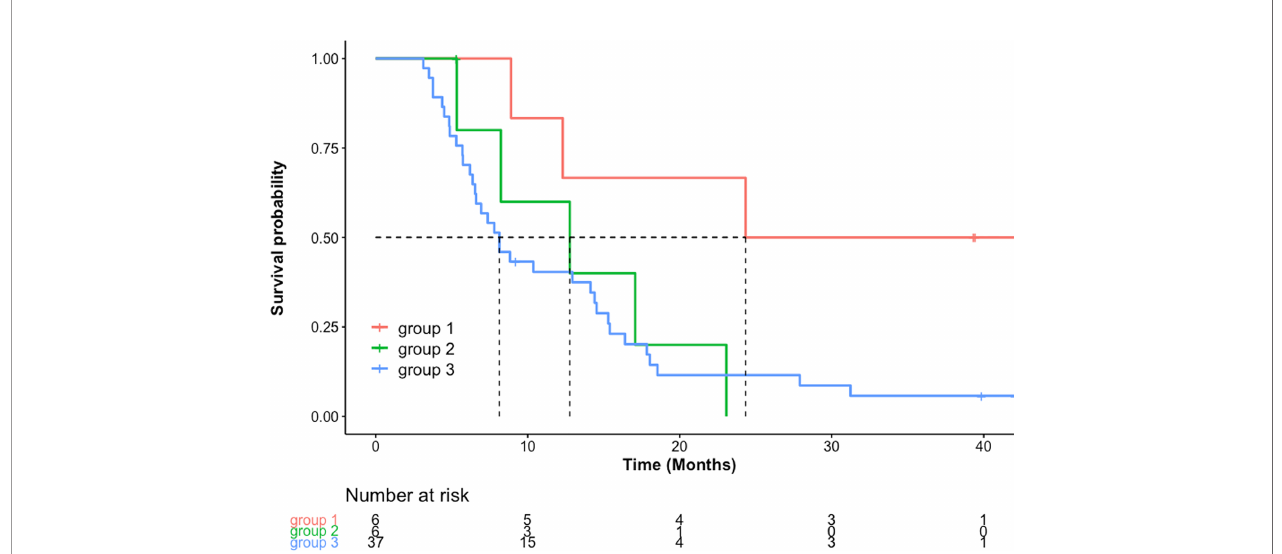
FIGURE 3 | OS in months [Kaplan-Meier estimated median and 95% con fi dence interval (CI), months] was signi fi cantly longer in group 1 [24.3 (12.3-not estimable)] compared to group 2 [12.8 (8.2 to not estimable)] (p=0.05) and group 3 [8.1 (6.5 – 14.5) (p=0.01)]. There was no signi fi cant difference in median OS between group 2 and group 3